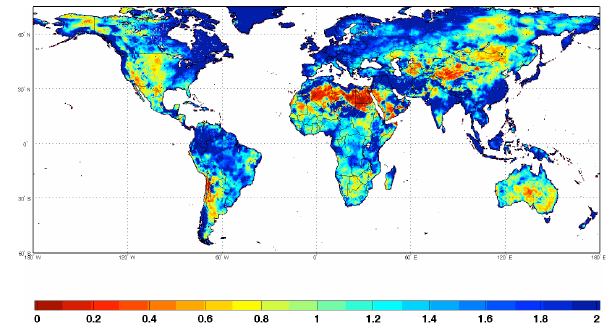
Fig. 3. Map of global evapotranspiration (in mm) distribution for the year 2006. Data are from Global Land-surface Evaporation: Ams- terdam Method (GLEAM).